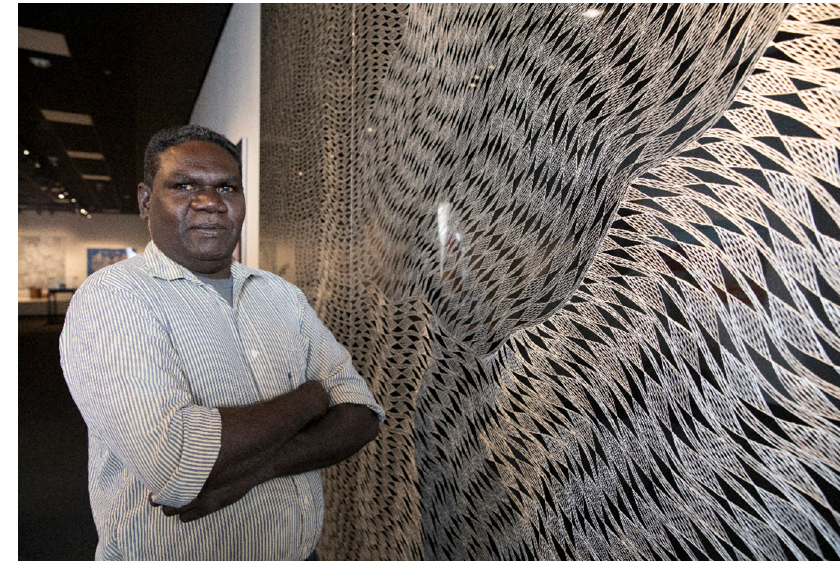
Figure 1. Gunybi Ganambarr and Bukyu , 2018, overall winner of the 2018 Telstra National Aboriginal and Torres Strait Islander Art Awards. Image courtesy MAGNT, photo: Fiona Morrison.